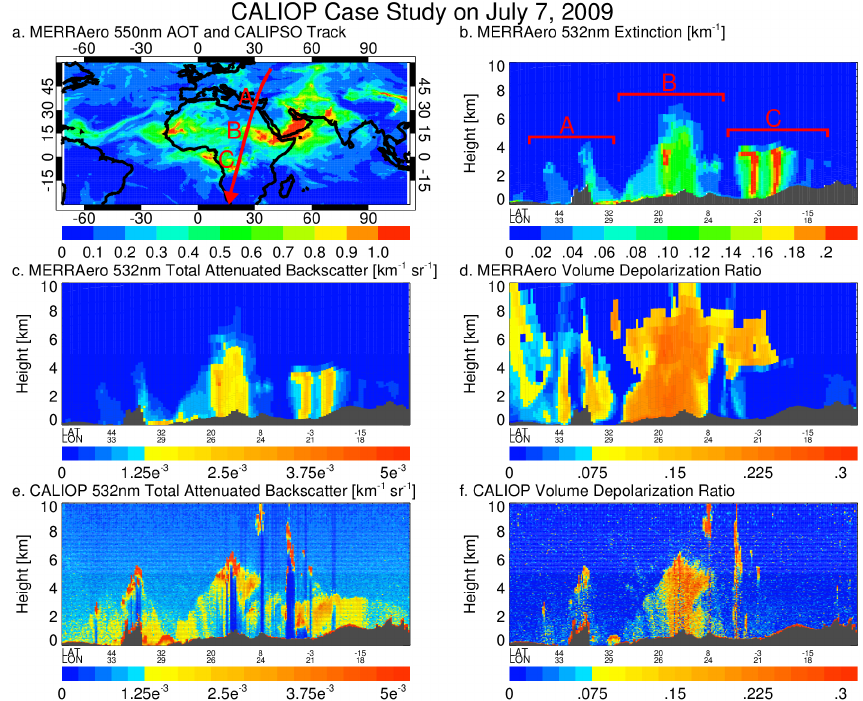
Figure 5. (a) MERRAero 550nm total AOT at 00:00UTC and CALIPSO track from 00:00 to 01:00UTC over three different aerosol regimes, (b) MERRAero 532nm total extinction, (c) MERRAero 532nm total attenuated backscatter, (d) MERRAero volume depolarization ratio, (e) CALIOP 532nm total attenuated backscatter, and (f) CALIOP volume depolarization ratio on 7 July 2009.